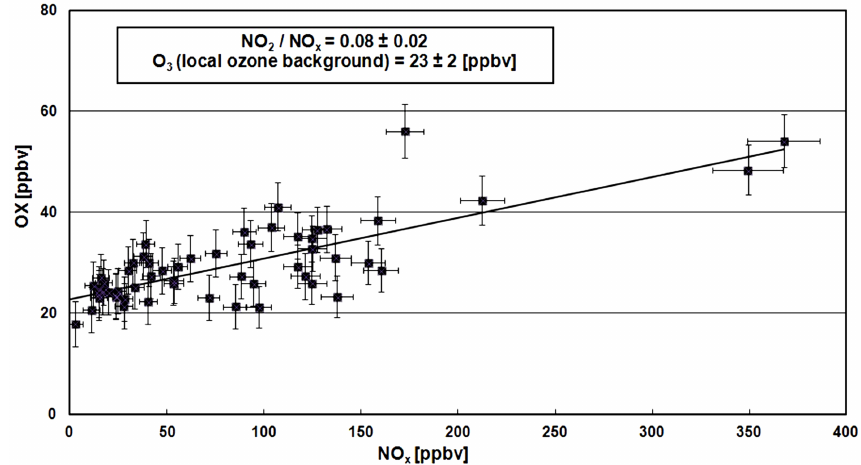
Figure 3. Plot of O x vs. NO x